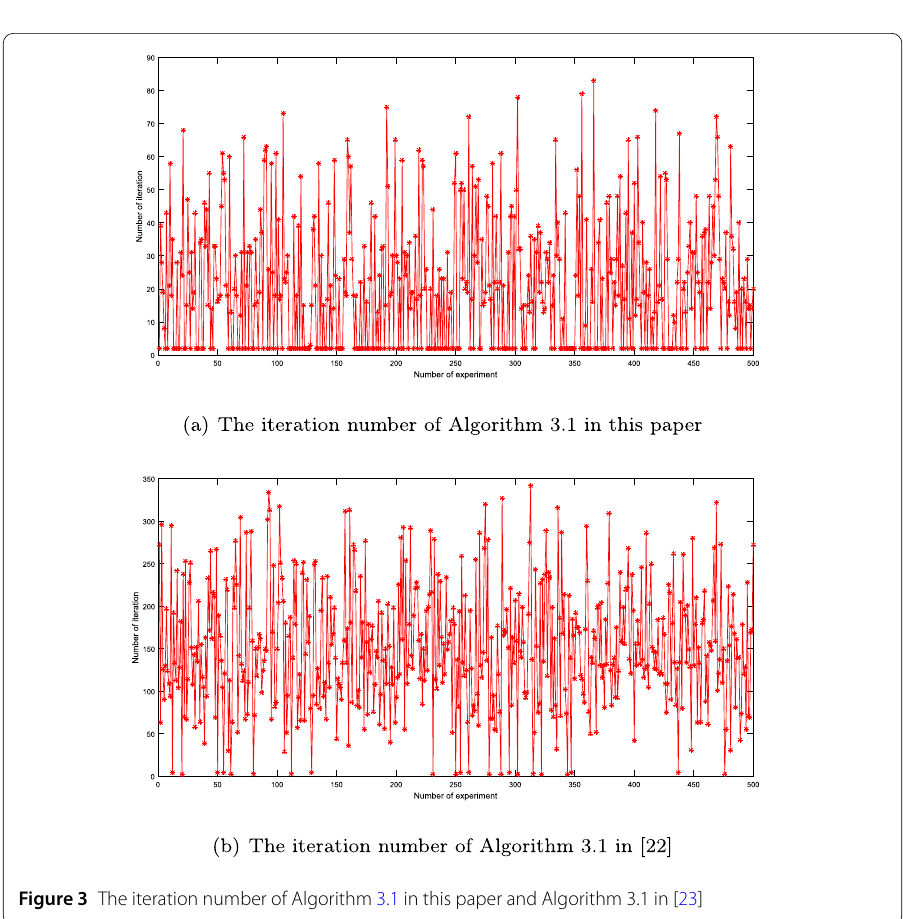
Figure 3 The iteration number of Algorithm 3.1 in this paper and Algorithm 3.1 in [23]